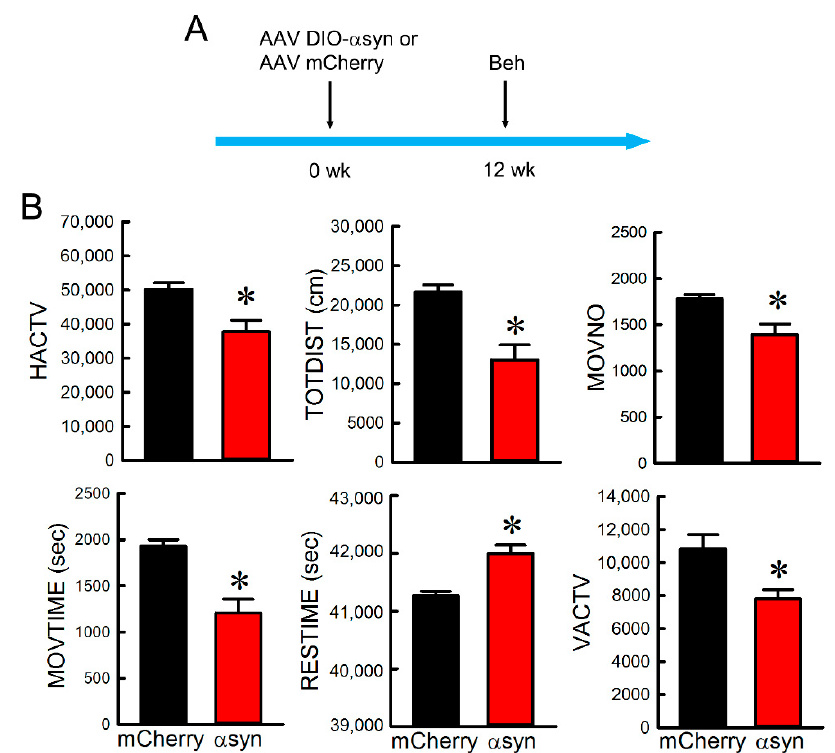
Figure 5. Administration AAV-DIO- α Syn to nigra induced bradykinesia in DAT-Cre rats. ( A ) Timeline of experiment. Animals receiving AAV-DIO- α Syn or AAV-mChery were placed in infrared locomotor activity chambers for 12 h (7 p.m. to 7 a.m.) during the dark cycle. ( B ) Intranigral administration of AAV-DIO- α Syn significantly reduced HACTV, TOTDIST, MOVNO, MOVTIME, and VACTV, while increased RESTIME. * Significant difference determined by t -test. Table 1. Significant improvement in locomotor behaviors after administration of AAV-NAC32 in rats overexpressing α Syn. * Two-Way